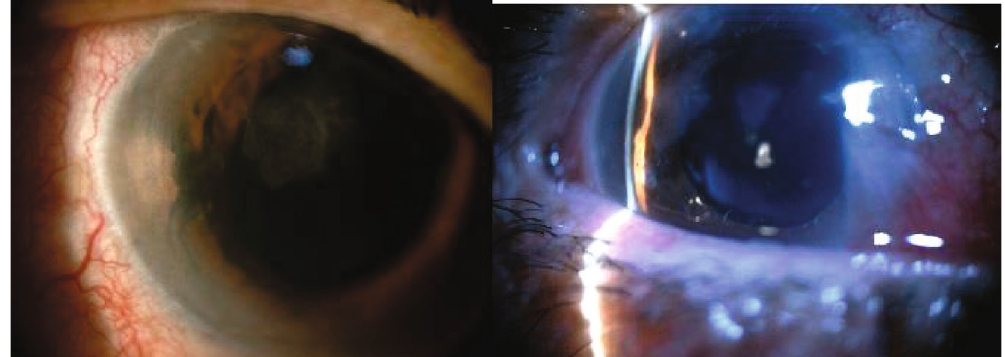
Figure 1: Slit lamp photograph of the right eye shows focal irido-corneal adhesion before argon laser synechiolysis.